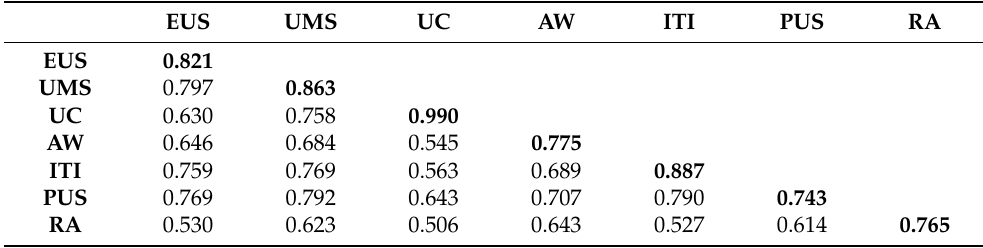
Table 3. Discriminant validity